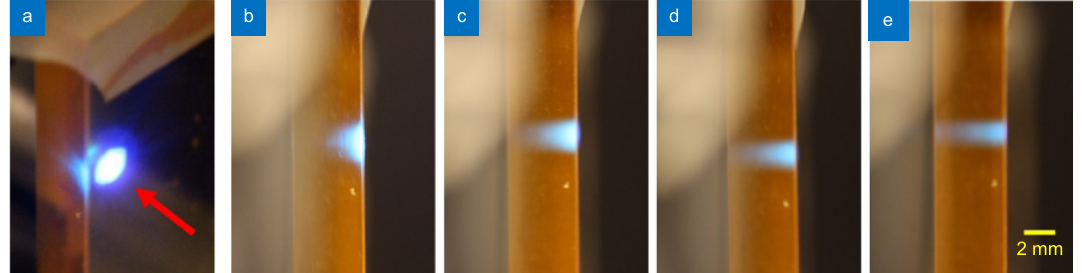
Fig. 10 | Fluorescence penetration depth with different pulse duration. ( a ) pump the sample with 775 nm fs laser, ( b ) τ ac = 0.26 ps, ( c ) τ ac = 1.7 ps, ( d ) τ ac = 4.5 ps, ( e ) τ ac = 6.5 ps. Sample thickness is 3.8 mm. Fluorescence appears deeper in sample as incident intensity decreases. Peak intensities are 25 GW cm –2 , 4 GW cm –2 , 1.5 GW cm –2 , 1 GW cm –2 respectively.